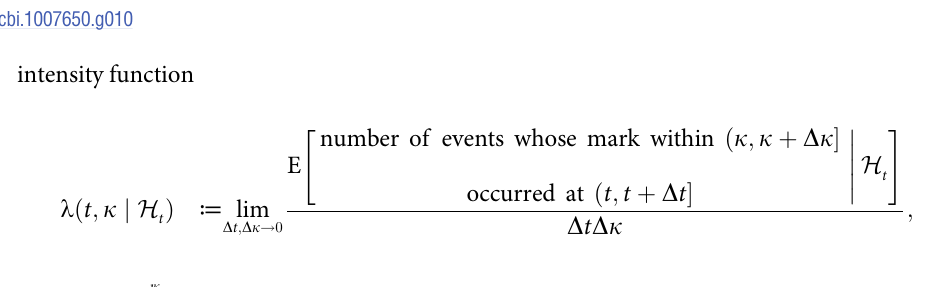
Fig 10. Spike generation model. Given the external stimulus x , the marked spike sequences κ are generated from the marked point process whose intensity is λ ( κ j x , ξ ). Each mark in these sequences indicates a fluorescent footprint of a spike emitted by each neuron, and this mark is expressed as a transformed version G κ in this figure. Because each neuron in the movie has a characteristic fluorescent footprint and a characteristic receptive field r for stimulus x , λ ( κ j x , ξ ) can be expressed as the multimodal function with peaks corresponding to each neuron. The blue and green components indicate the mean florescent footprints and the receptive fields of two different neurons,